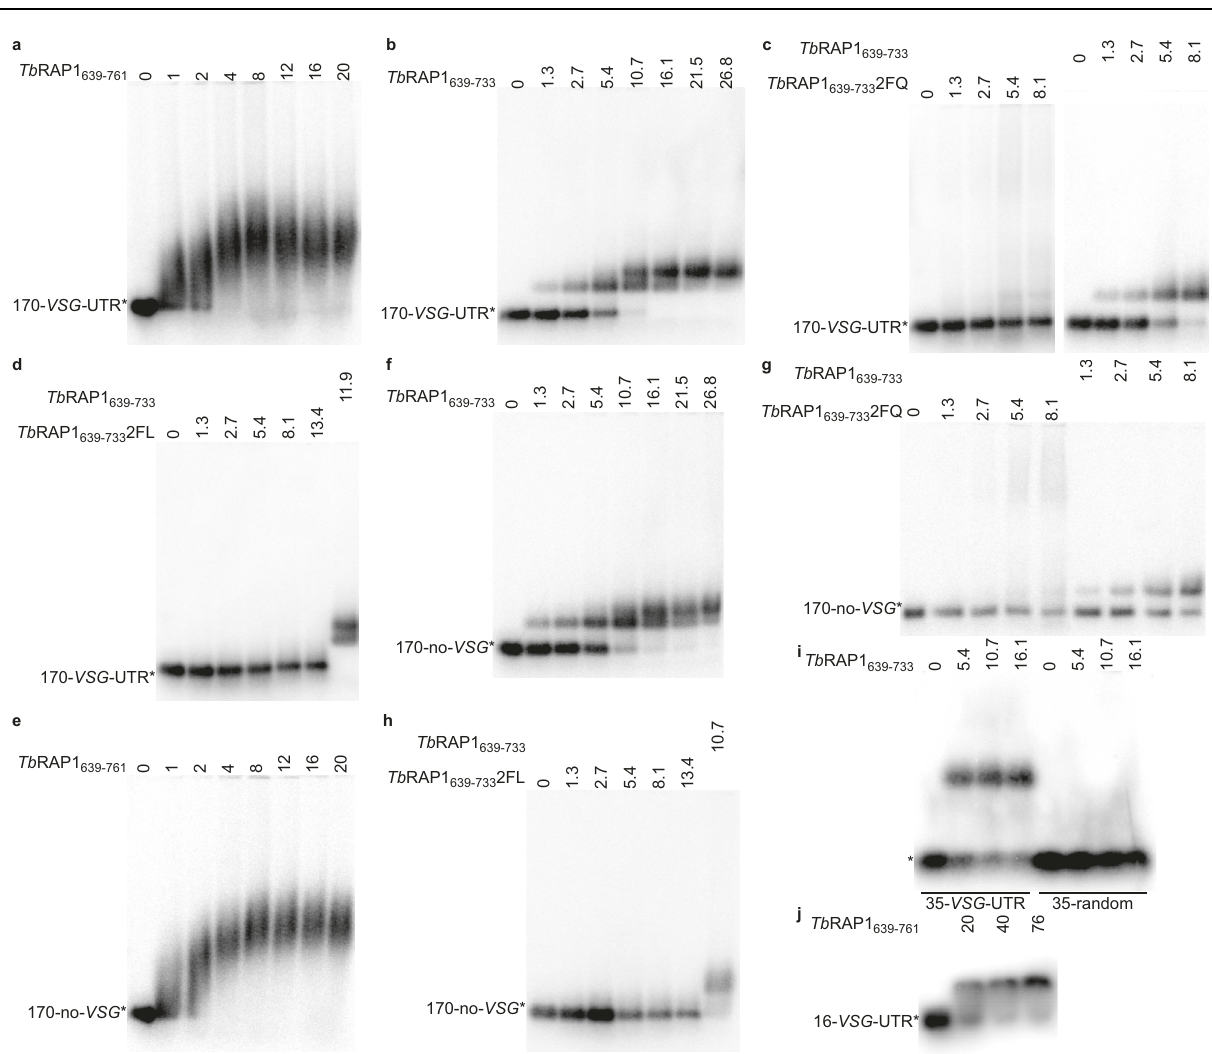
Table 2). The concentration of protein ( µ M) used in each reaction is indicated on topofeachlane.Sampleswereelectrophoresedin0.8%agarosegels( a – i – d ),